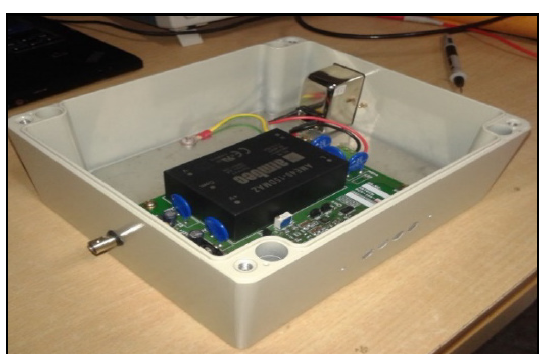
Fig. 11: Prototype Distributed Interlock Module (DIM)